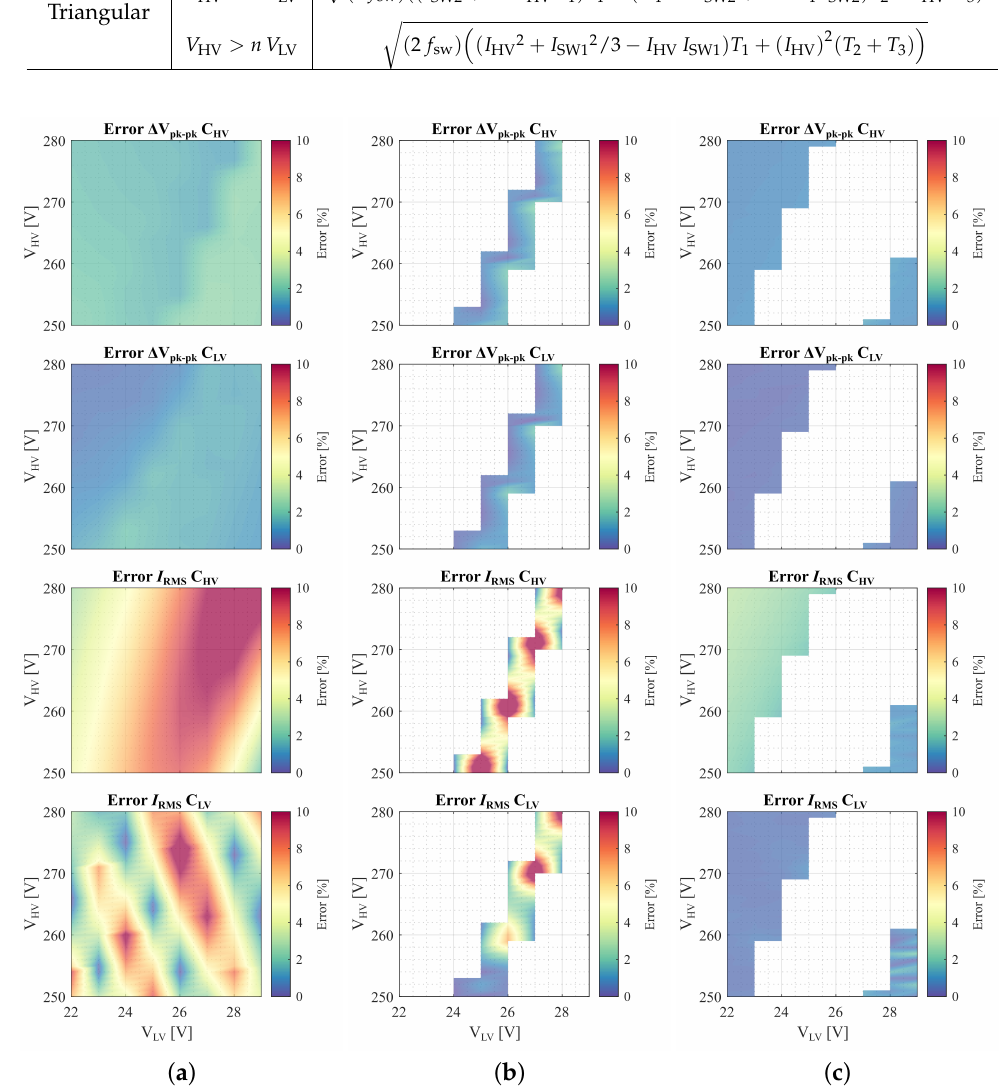
Figure A1. Validation of the RMS and peak-to-peak voltage ripple analytical equations presented in this work based on a simulation model developed in PLECS: ( a ) SPS rectangular modulation, ( b ) TPS-TPM and ( c )